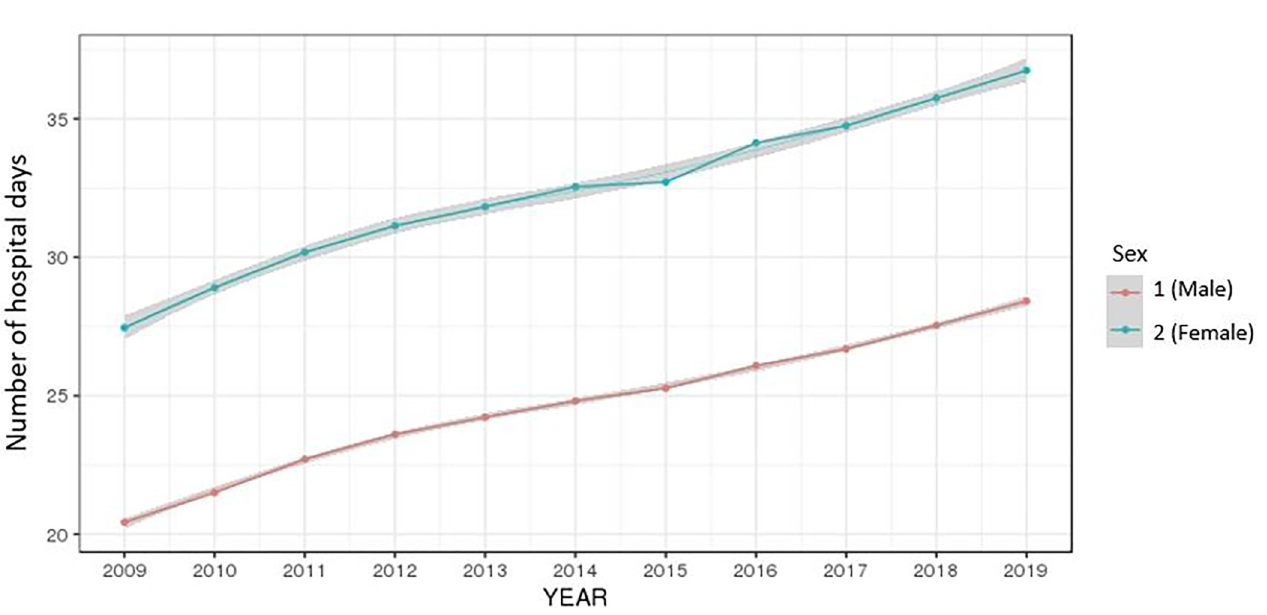
Fig 6. Ten-year trend of the number of days in hospital by